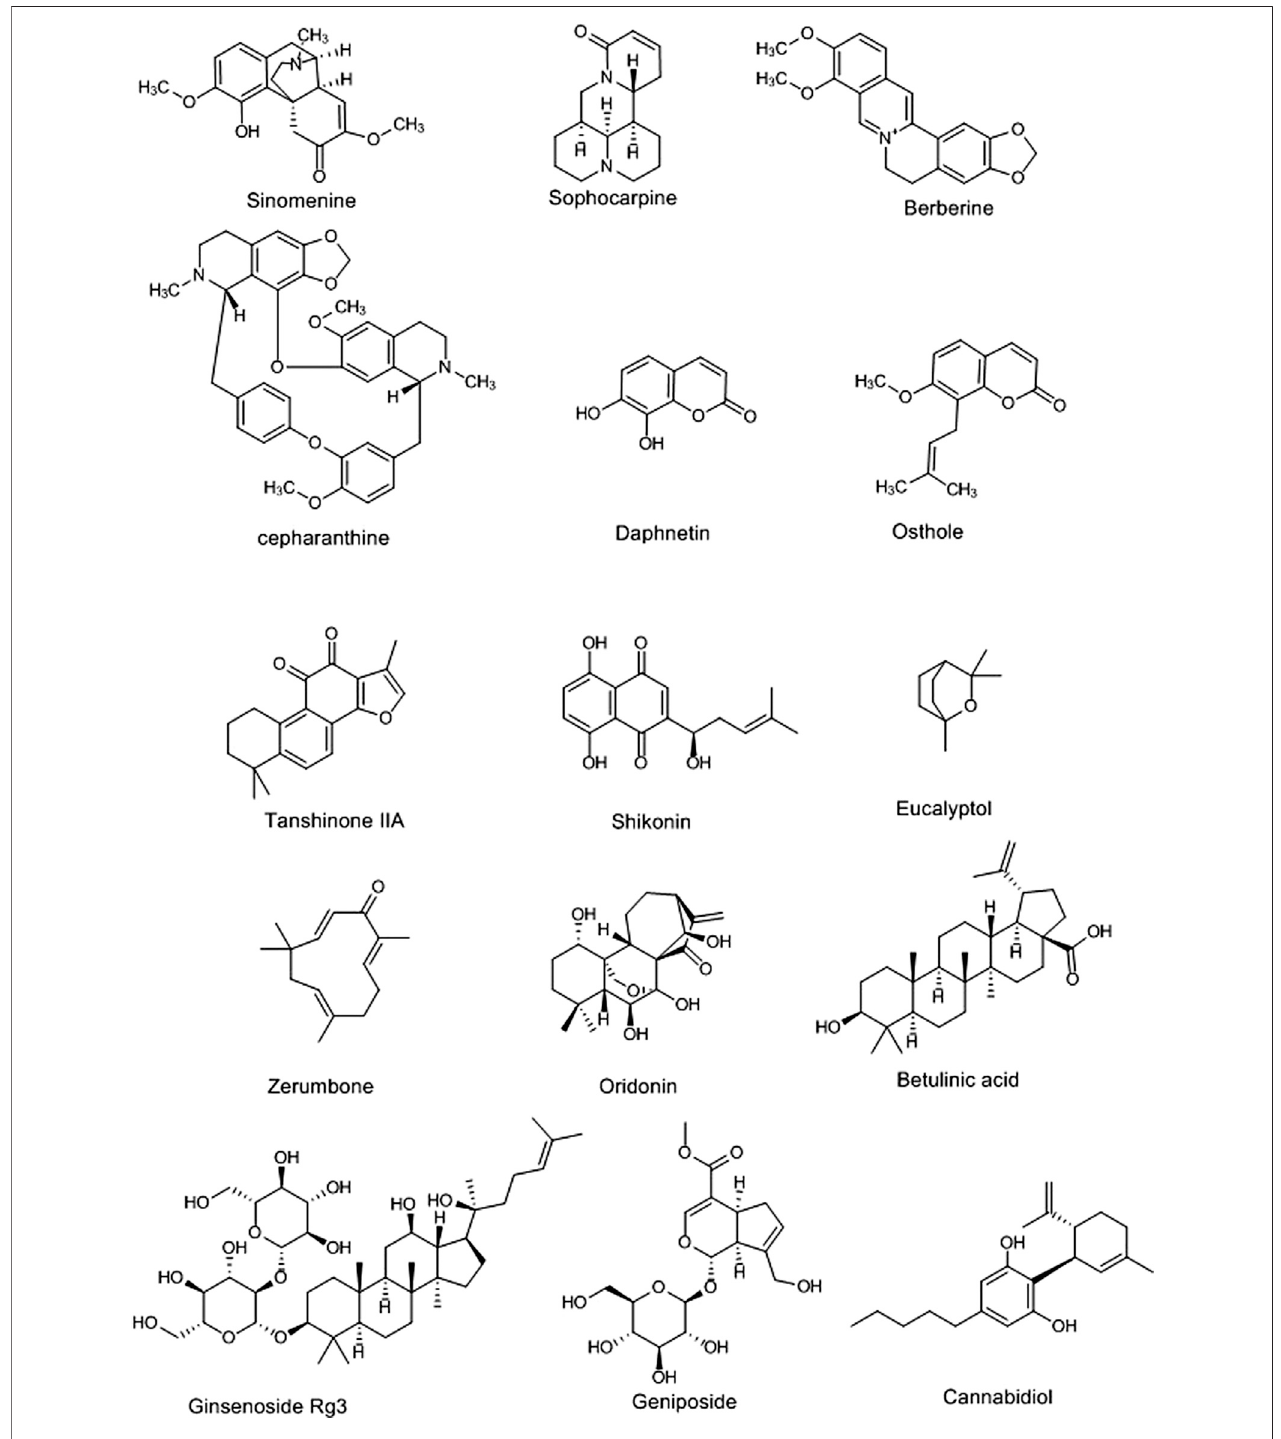
FIGURE 3 | Selected chemical structures of alkaloids, coumarins, terpenes, quinones, and other phytochemicals with potential protective effects against lung injury.